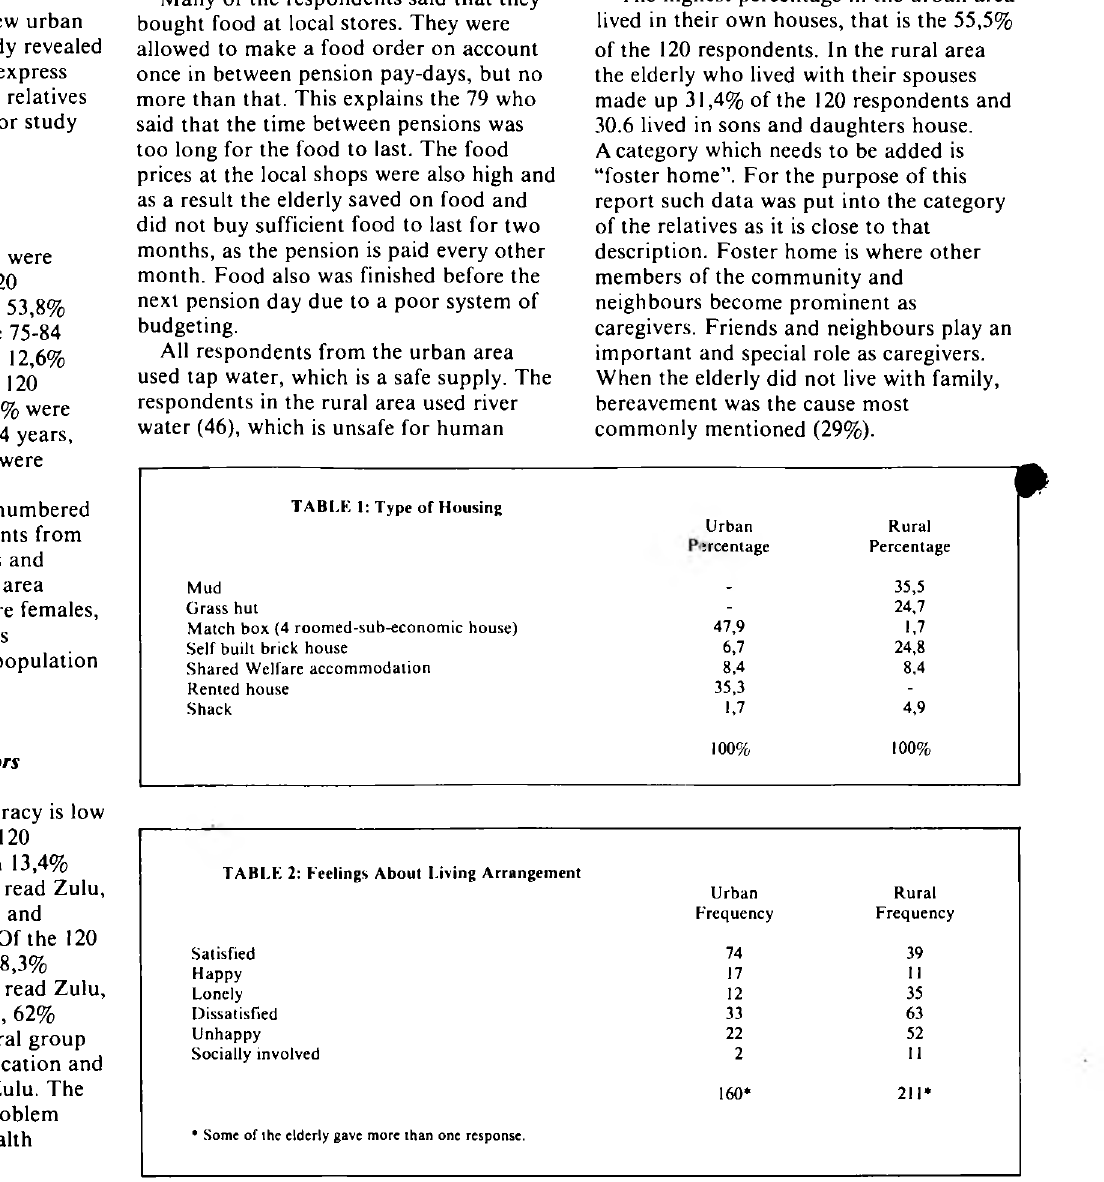
TABLE 2: Feelings About Living Arrangement